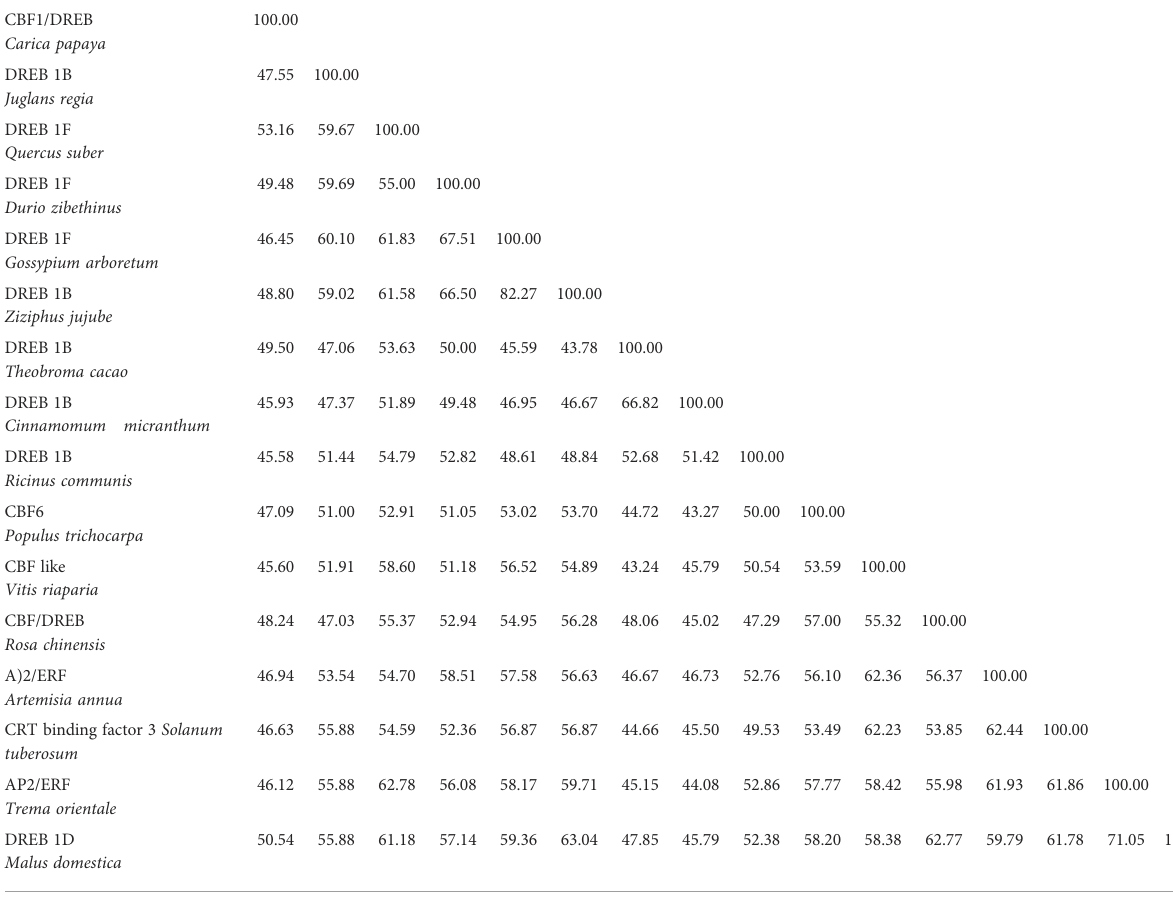
TABLE 3 Percent identity matrix of Carica papaya CBF1/DREB with other plants CBF/DREB factors (Table adapted from Maurya et al., 2020). CBF1/DREB Carica